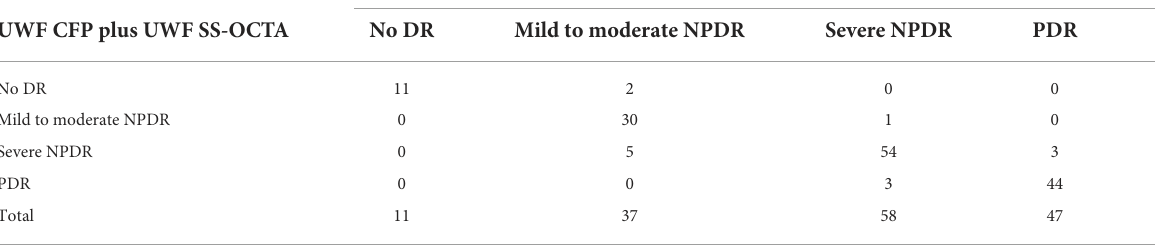
TABLE 5 Agreement in grading DR between UWF CFP plus UWF SS-OCTA vs. UWF CFP plus